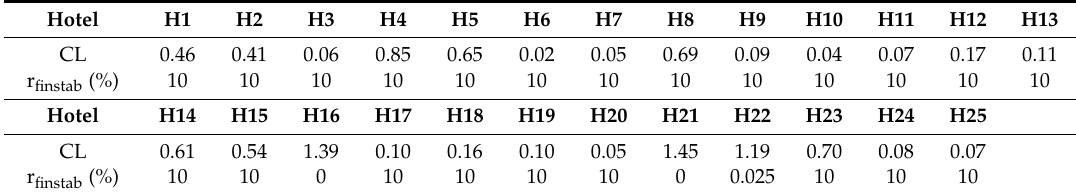
Table 9. Values of Current Liquidity and financial stability risk.